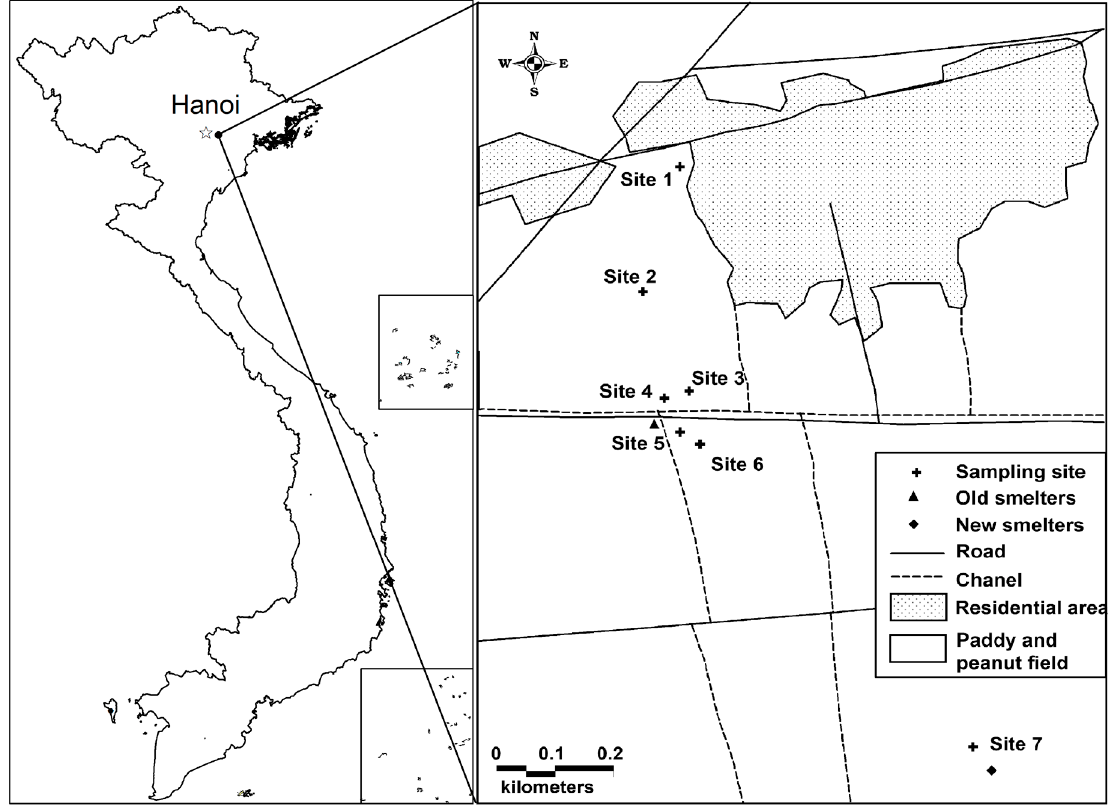
Figure 1. Sampling sites in the Dong Mai Pb recycling area, Hung Yen province, northern Vietnam (Site 1: Peanut field; Site 2: Peanut field; Site 3: Paddy field; Site 4: Path at edge of ditch; Site 5: Path at edge of ditch; Site 6: Path at the edge of the paddy field; Site 7: Paddy field).